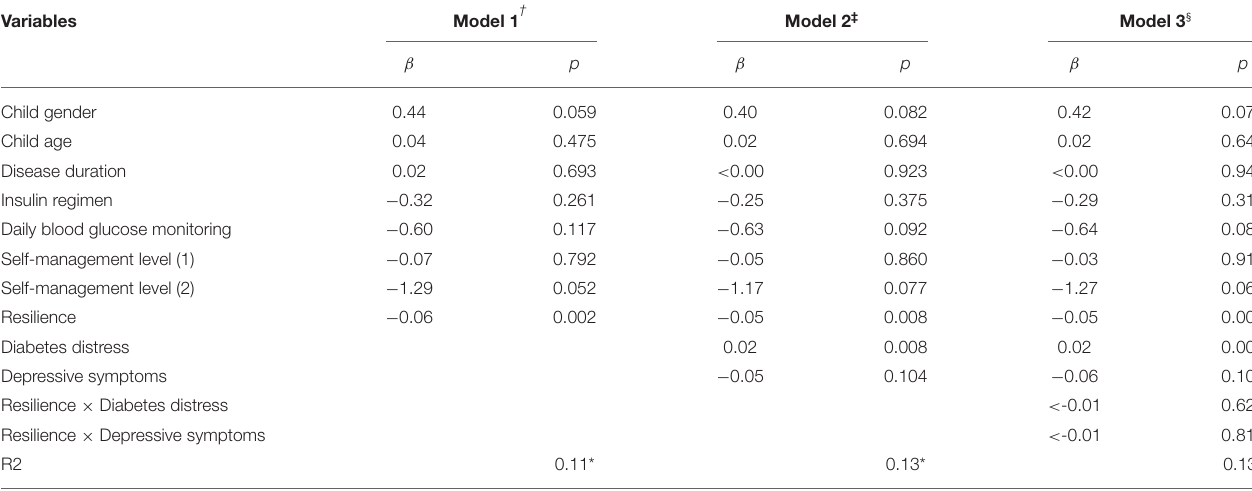
TABLE 3 | Regression analyses testing parent resilience as predictor of